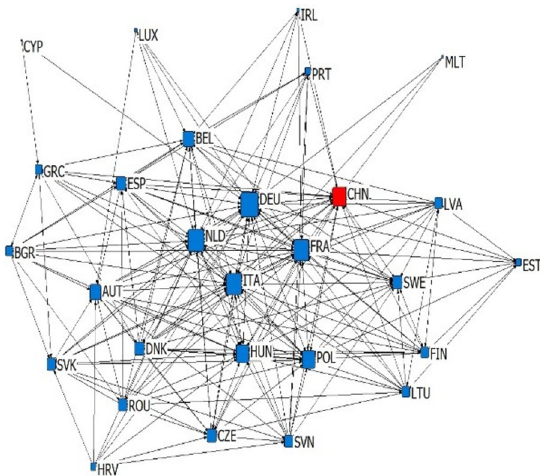
Fig 8. Lower vertical intra industry import dependence